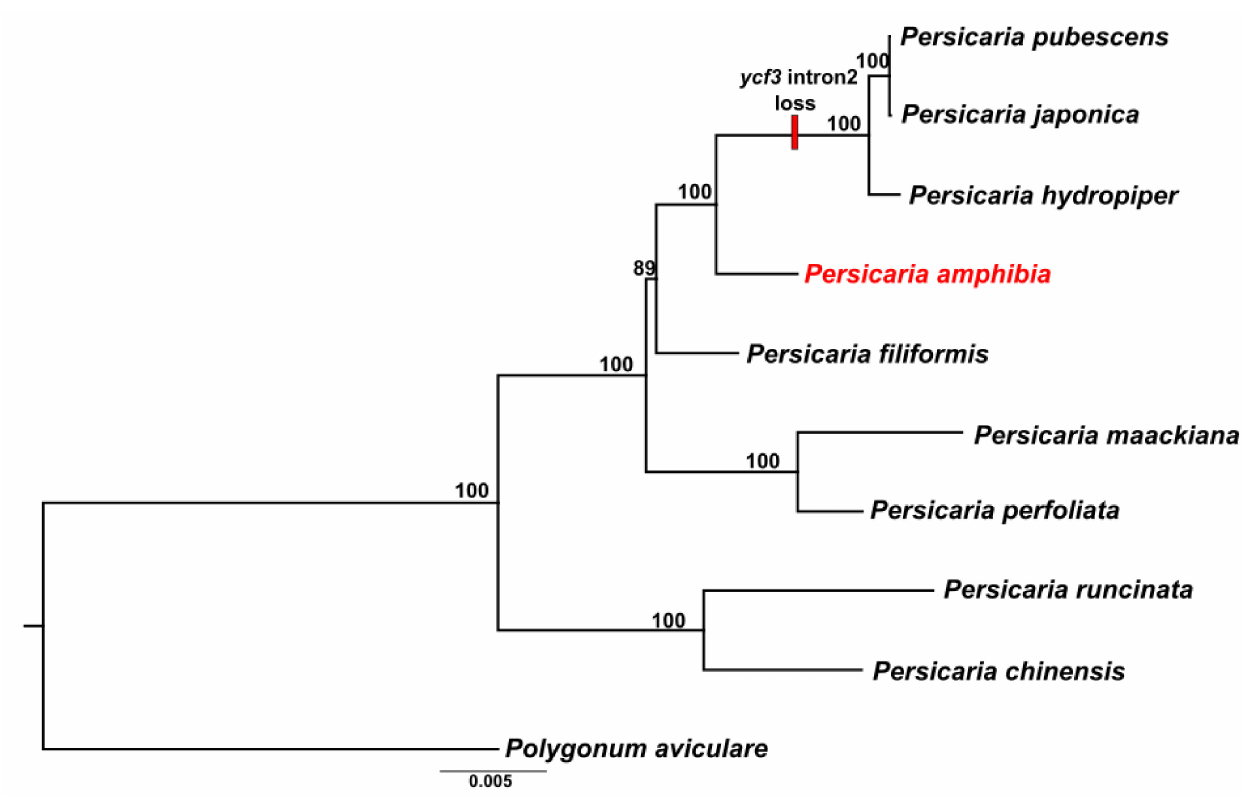
Figure 7. Phylogenetic tree reconstruction of 9 Persicaria species and one outgroup based on the 77 protein-coding genes (66,732 bp). Number above branches are bootstrap